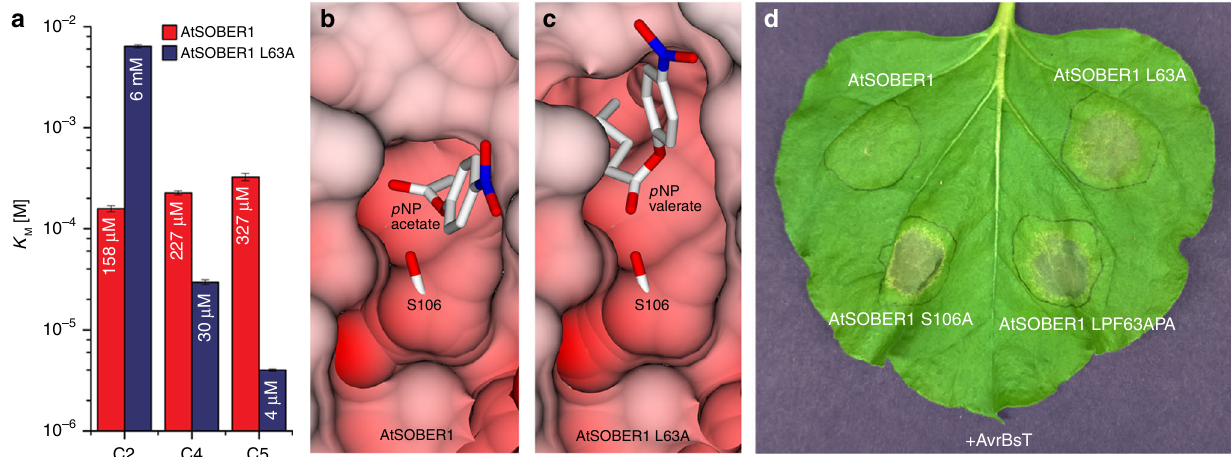
Fig. 3 Altering SOBER1 protein surface changes substrate speci fi city and biological function. a K M values of AtSOBER1 wt and L63A to p NP acetate (C2), p NP butyrate (C4), and p NP-valerate (C5). Data were measured in triplicates and error bars indicate standard deviation. b Docked p NP acetate into the catalytic site of wild type AtSOBER1. c Docked p NP-valerate into the catalytic site of AtSOBER1 L63A. d Transient co-expression of AtSOBER1 (wild type and mutant variants) with avrBsT in N.